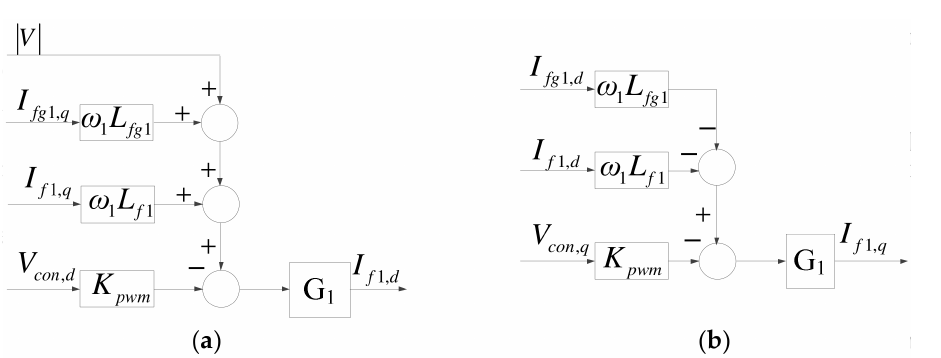
Figure 5. Mathematical models of grid inverter currents: ( a ) d axis; ( b ) q axis. K pwm = V dc /2 V tri ( V tri denotes carrier amplitude), and V con,d and V con,q denote dq-axis